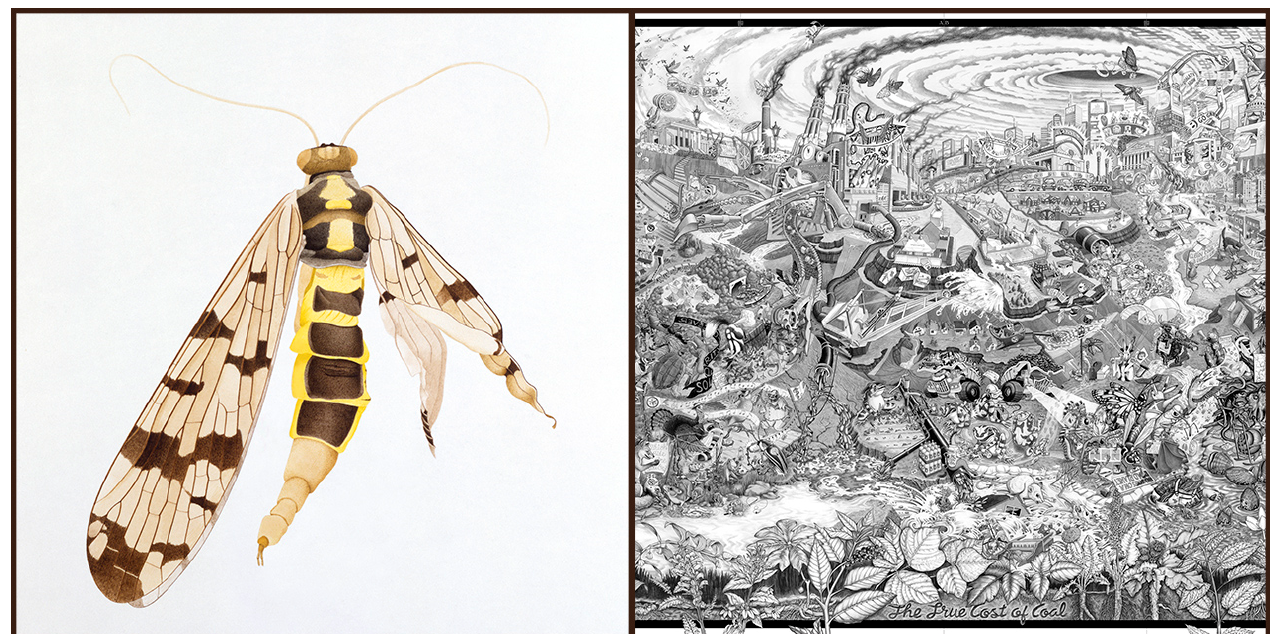
Figure 2. Insect art addressing pollution. Cornelia Hesse-Honegger has artistically and scientifically investigated and documented deformed insects within the vicinity of nuclear power plants for decades. Scorpionfly, Panorpidae ( left ; aquarell, 1988) records wing and abdomen deformities of a scorpionfly from Reuental, near nuclear power plant Leibstadt (image courtesy and copyright of the artist). In contrast to highlighting a single specimen on white, The Beehive Design Collective depicts multiple human impacts, including pollution’s effects on peppered moths (near smoke stacks), a caddisfly, and many others in The True Cost of Coal ( right: pen and ink, 2010; Creative Commons). Inspired by the back cover of Mad Magazine, this is only the central portion of a larger fold-out poster, featuring mountaintop removal and climate chaos.